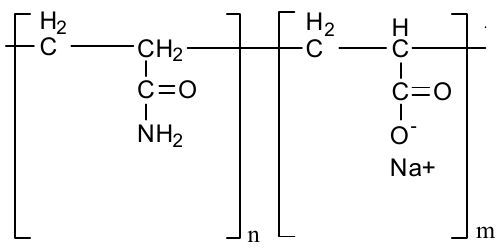
Figure 1. Chemical formulae of polymer flocculant based on acrylamide and sodium acrylate (PASA). Human serum albumin (HSA, M w = 66,400 g·mol − 1 , pI = 4.6; Sigma-Aldrich, St. Louis, MO, USA)